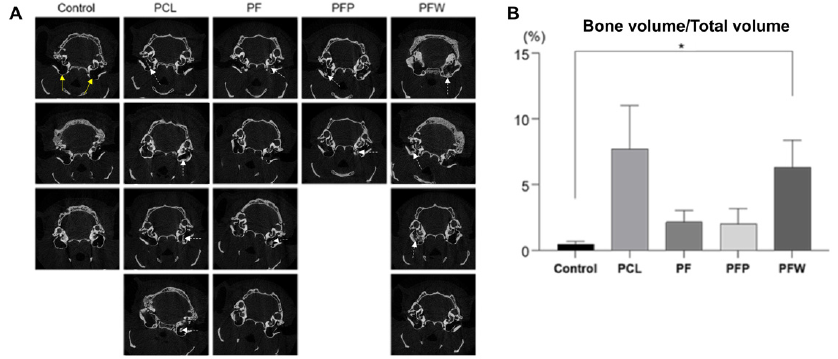
Figure 5. Measurement of newly formed bone by micro-CT. ( A ) After 7 months of follow up, bone tissue densities in SD rat mastoid cavities were observed by micro-CT. White dotted arrows are where the bone densities are relatively well observed. ( B ) The quantitative analysis of bone volume/total volume ratio represented that the PCL scaffold + fat + WP group had the highest bone volume/total volume ratio with a significant difference compared to the control group (defect). The yellow arrows indicate mastoid bulla defects. (Control group: defect only ( n = 3); PCL group: PCL 300 mg c 20 wt% without fat ( n = 4); PCL + fat group: PCL 300 mg c 20 wt% and fat 50 mg ( n = 4); PCL + fat + PRP group: PCL 300 mg 20 wt%, fat 50 mg, and PRP 50 uL ( n = 2); PCL + fat + WP group: PCL 300 mg c 20 wt%, fat 50 mg, and WP 50 uL ( n = 4)), PRP: platelet-rich plasma, WP: whole plasma,